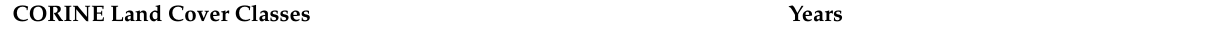
Table A1. Detailed Land cover statistics in Karasu Basin for the selected years using CORINE land cover data. CORINE Land Cover Classes